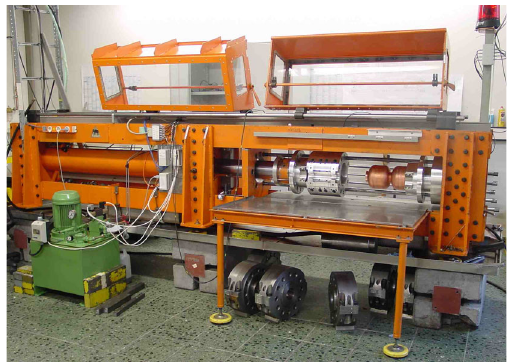
FIG. 12. The hydroforming machine.